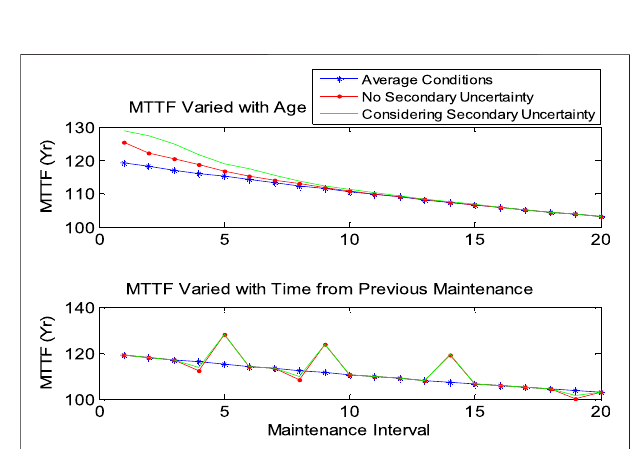
FIGURE 13 | MTTF variation of the circuit breaker with each individual operation